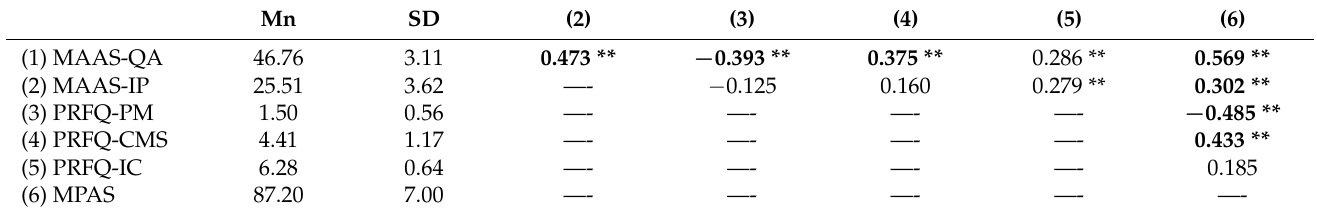
Table 2. Descriptive Statistics and Spearman correlations among the main studied variables (N 110).